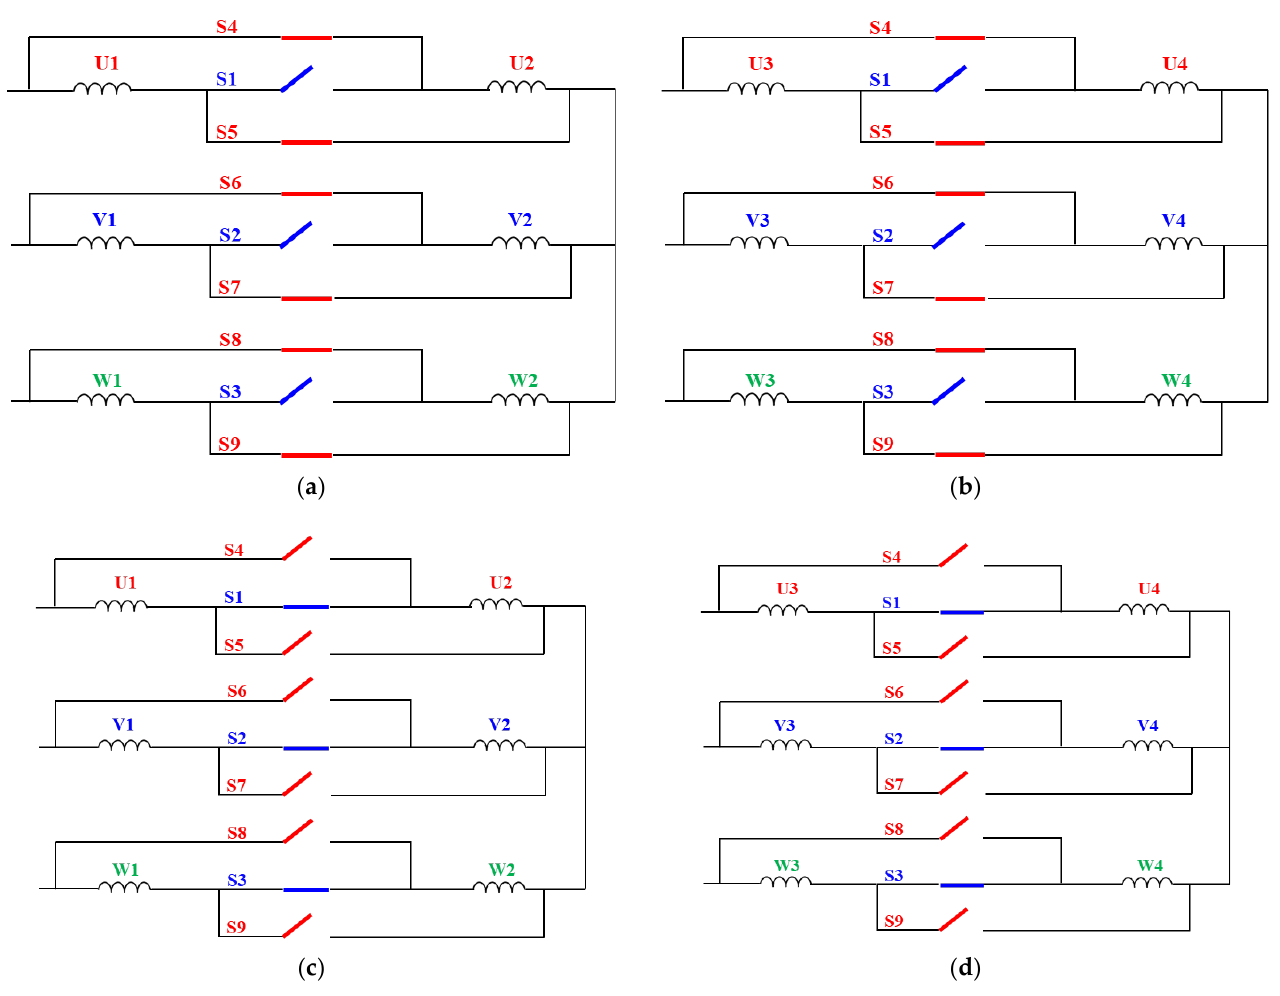
Figure 14. Proposed winding switching method: ( a ) Mode I of master part; ( b ) Mode I of slave part; ( c ) Mode II of master part; ( d ) Mode II of slave part.